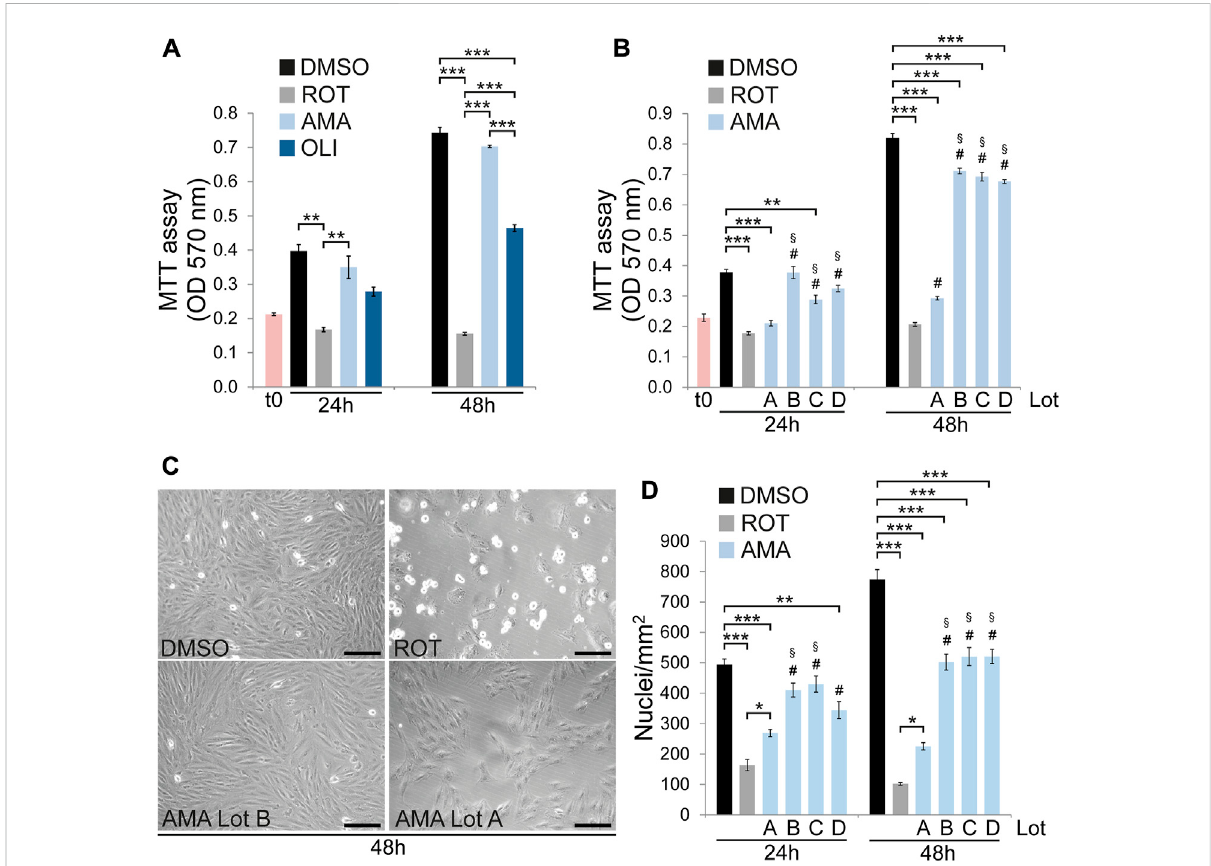
FIGURE 1 H9c2 cells partially tolerate mitochondrial complex III but not I or V inhibition. (A) MTT assays of H9c2 cells treated with DMSO (included as control),rotenone(ROT,10 µM),antimycinA(AMA,50 µM)andoligomycin(OLI,5 µM)for24and48 h. (B) MTTassaysofH9c2cellstreatedwithROT (10 µM) and four different lots of AMA (50 µM each) for 24 and 48 h. (C) Phase contrast microscopy images of H9c2 cells treated with DMSO, ROT and AMA lots A and B [same as in (B)] for 48 h (scale bar = 200 µm). (D) Nuclear density of H9c2 cells treated with ROT and four different lots of AMA [same as in (B)] for 24 and 48 h. ( n = 4 wells per treatment in (A) , (B) and (D) , * p < 0.05, ** p < 0.01, *** p < 0.001, # p < 0.001 versus ROT, § p < 0.001 versus AMA Lot A. t0 in (A) and (B) represents MTT values at the onset of